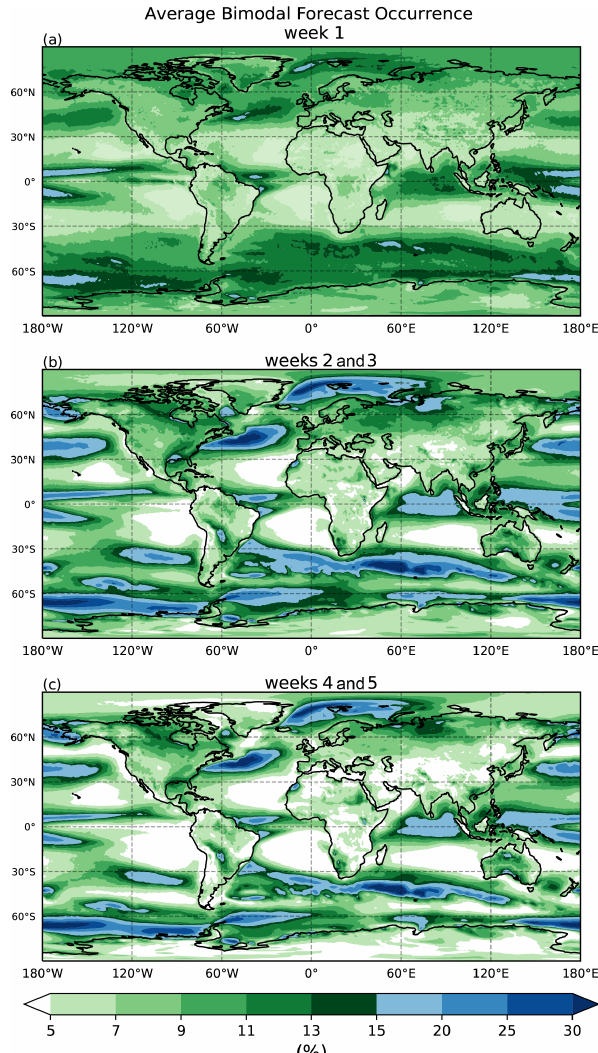
Figure 5. (a) The average occurrence of forecasts that are consid- ered bimodal in the first week of lead times, (b) in weeks two to three, and (c) in weeks four to five for the ECMWF 2m tempera- ture